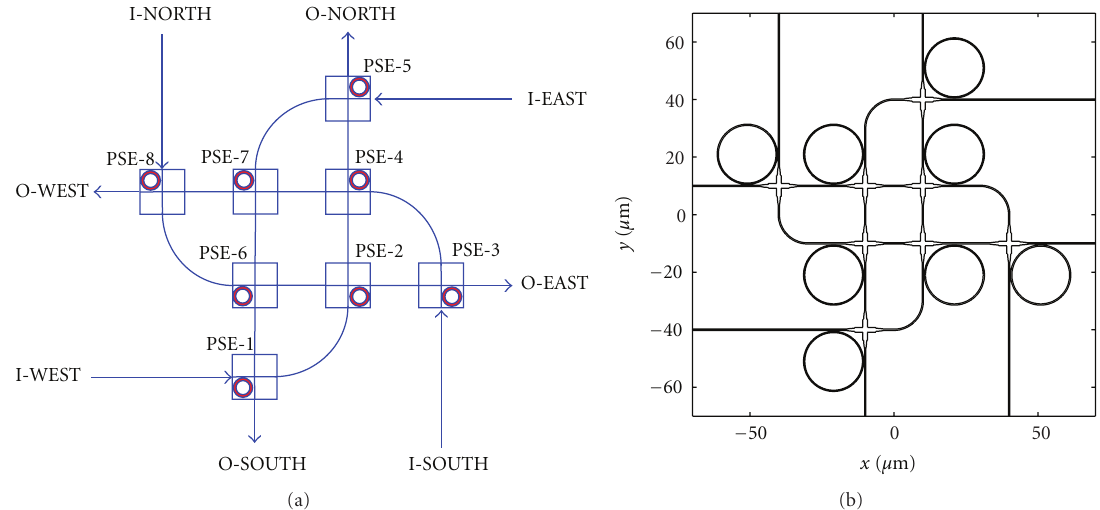
Figure 5: (a) Topological scheme of the 4 × 4 optical switch showing the interconnections between the eight PSEs. (b) FDTD representation of the real device; the computational domain is discretized over a grid with step dx = dy = 1 / 30 μ m.